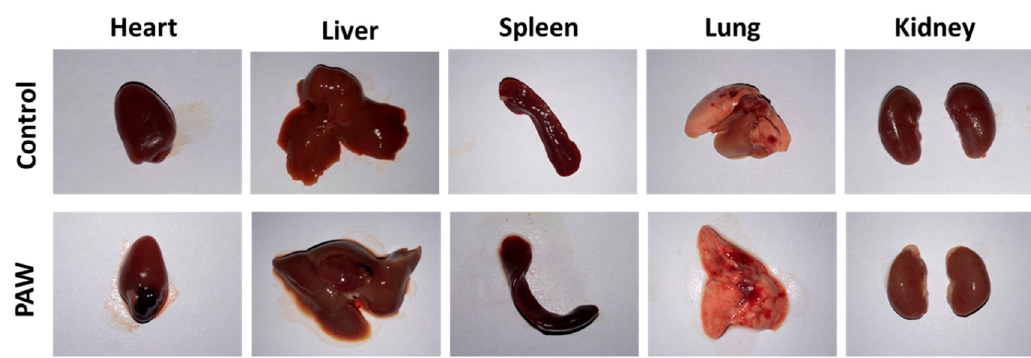
Figure 6. The effect of PAW on the external morphology of selected internal organs in mice.